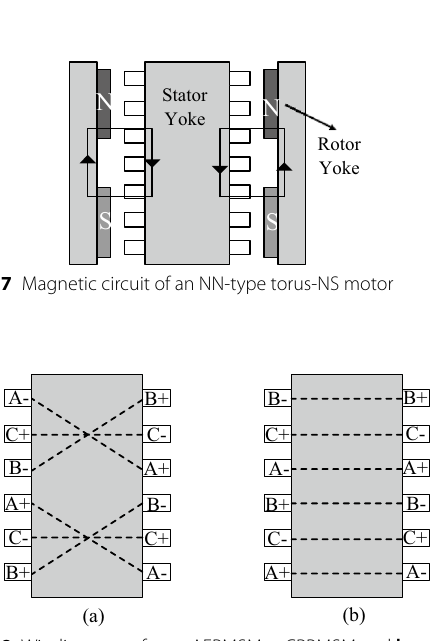
Figure 8 Winding types for an AFPMSM: a CRPMSM and b torus-NS PMSM